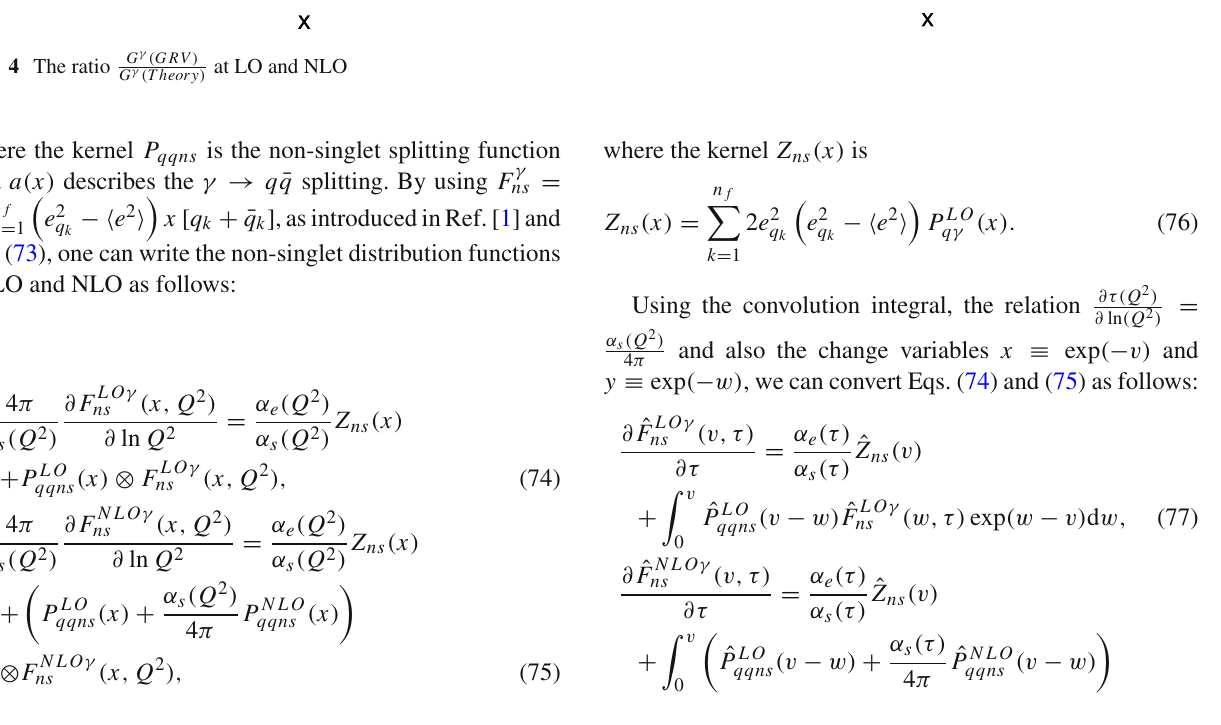
Fig. 4 The ratio G